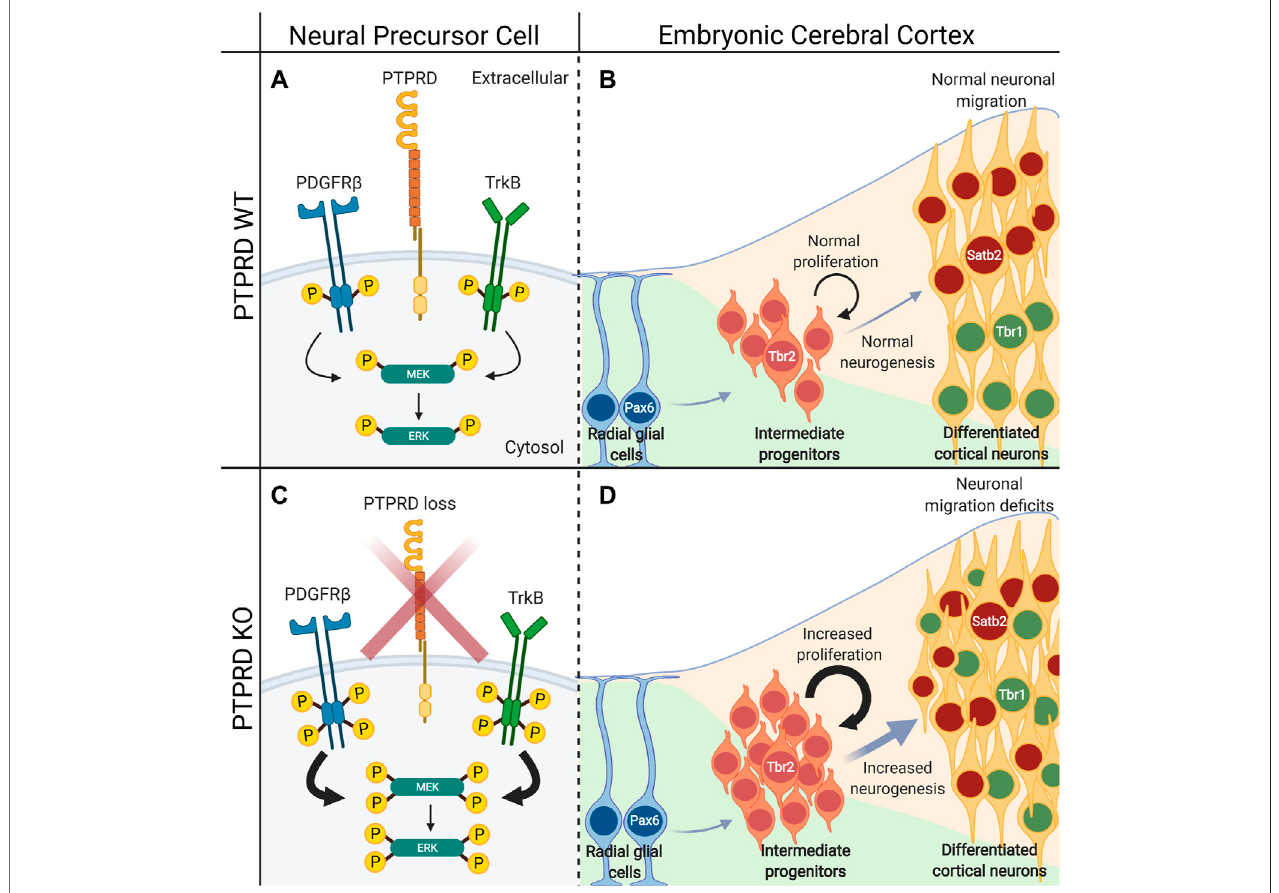
FIGURE 5 | PTPRD absence induce aberrant embryonic cortical neurogenesis. (A) PTPRD dephosphorylates PDGFR β and TrkB receptor tyrosine kinases to control their activity, and the activation of MEK/ERK intracellular signaling. (B) This induces the normal Tbr2-positive intermediate progenitor cells proliferation and neurogenesis, and the correct localization of Satb2 and Tbr1-positive neurons into the brain cortex. However (C) when PTPRD expression is lost, NPCs have increased phosphorylation of PDGFR β and TrkB, which derives in the hyperactivation of the MEK/ERK intracellular signaling. (D) This induces an increase in Tbr2-positive intermediateprogenitorcellproliferation,andconsequently,aberrantincreasedneurogenesisandimpairedpositioningofSatb2andTbr1-positiveneuronsintothebrain cortex.